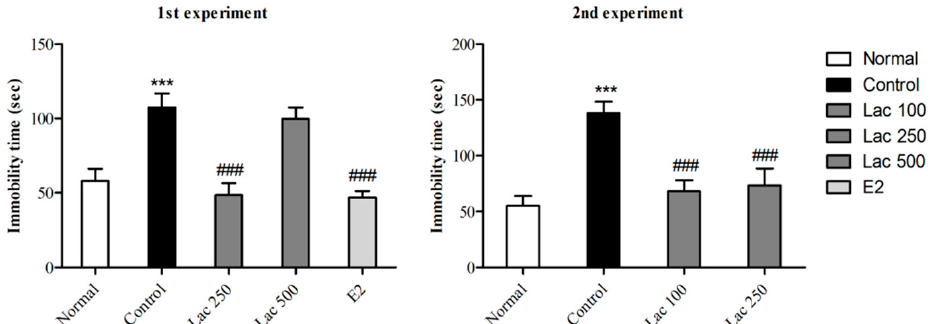
Figure 2. Effect of oral lactate administration on ovariectomized rats with stress in tail suspension tests (TST). Oral lactate administration (100 and 250) and estradiol decreased immobility time significantly compared to the control group. Values are presented as mean ± standard error of the mean (SEM). *** show the difference between the normal and control groups, while ### show significant differences between the control group and treatment groups. *** and ### p < 0.001. The p value of the test was < 0.001 by one-way ANOVA, followed by a post hoc LSD test.